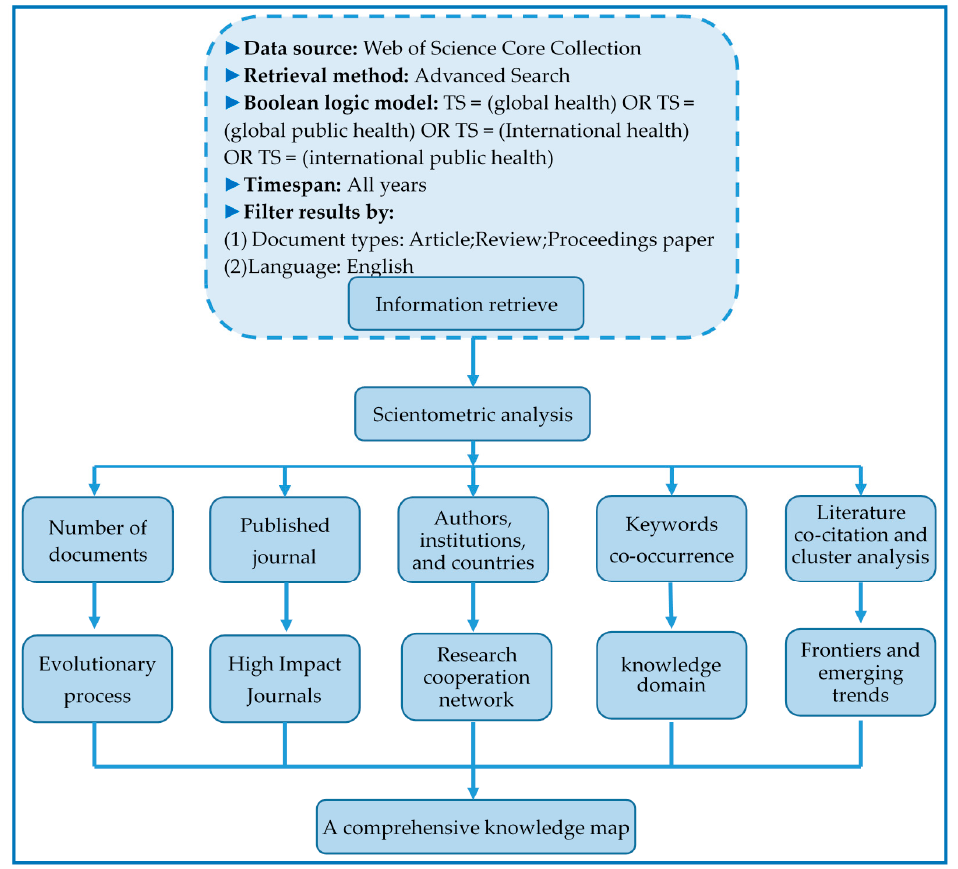
Figure 1. Research Figure 1. Research framework.